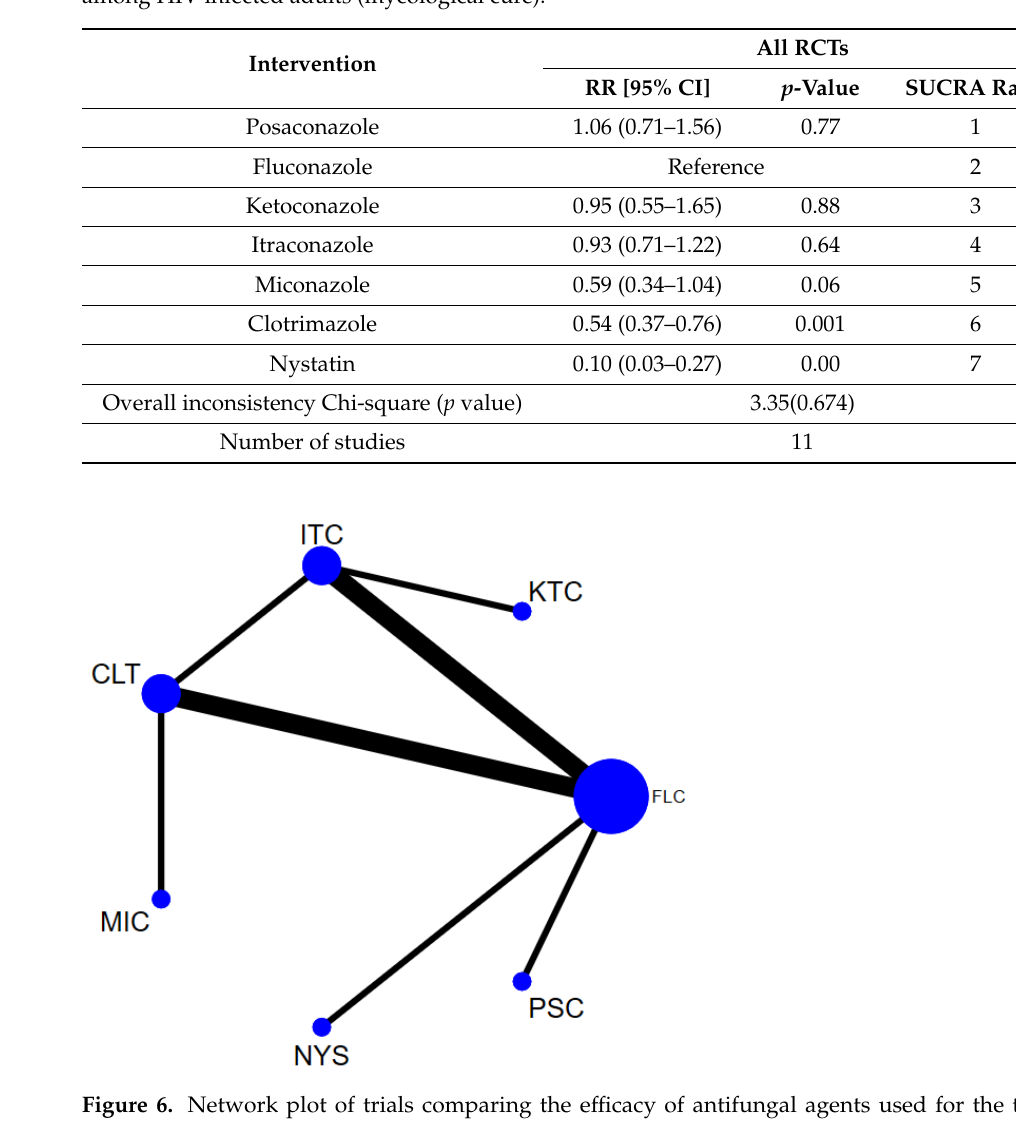
Table 3. NMA estimates and SUCRA ranking of antifungal agents used for the treatment of OPC among HIV-infected adults (mycological cure).